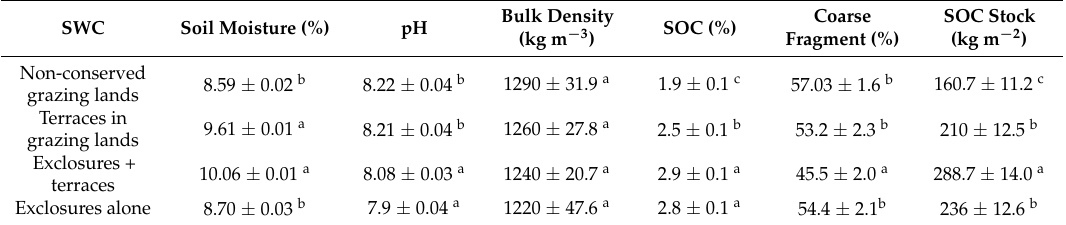
Table 2. Mean values of soil properties in response to SWC measures 30 cm depth (mean ±